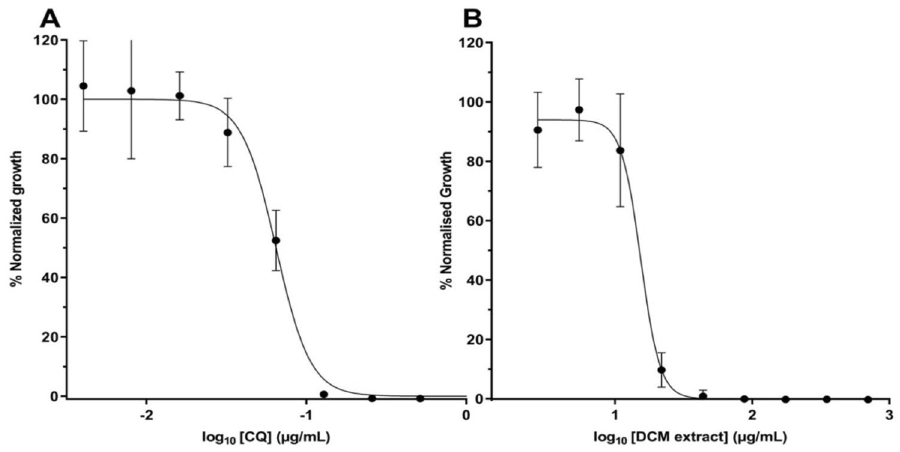
Figure 2. Determination of the EC 50 of the dichloromethane (DCM) fraction of sugarcane leave extract. Normalised growth of parasites exposed to ( A ) chloroquine (CQ) and ( B ) DCM fraction. Data presented as mean ± standard deviation of normalised growth (n ≥ 6) versus concentration of the fraction.